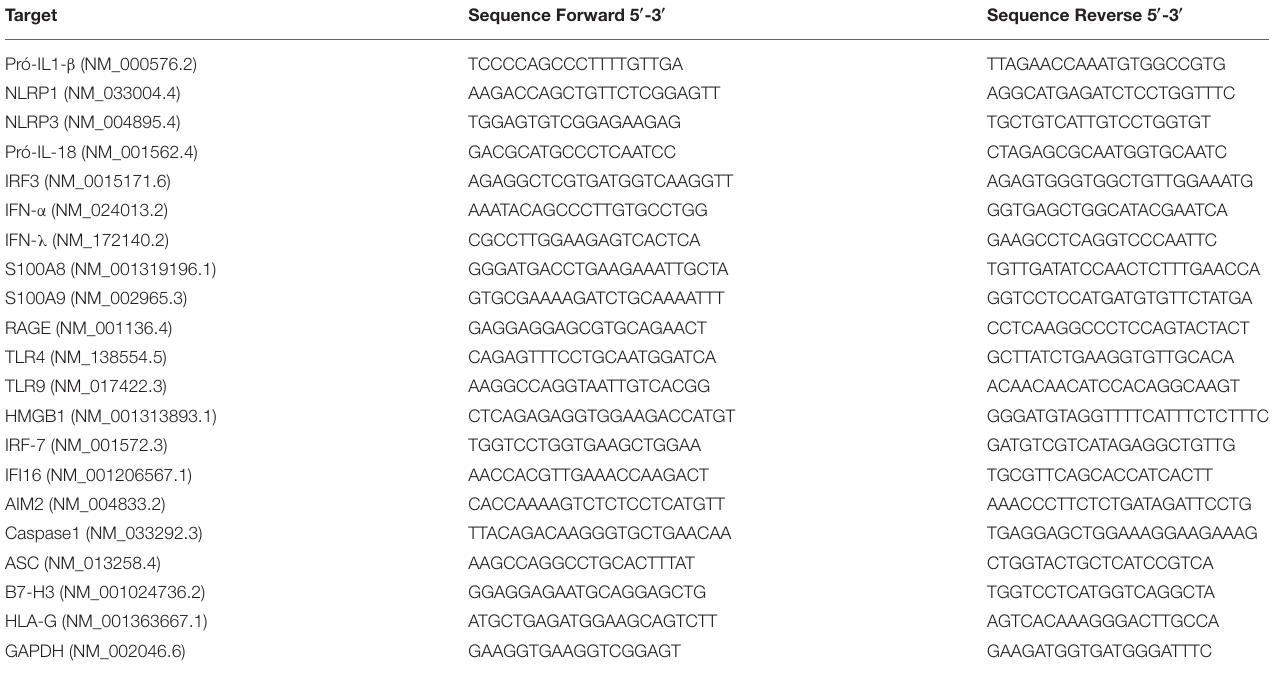
TABLE 2 | List of oligonucleotides.